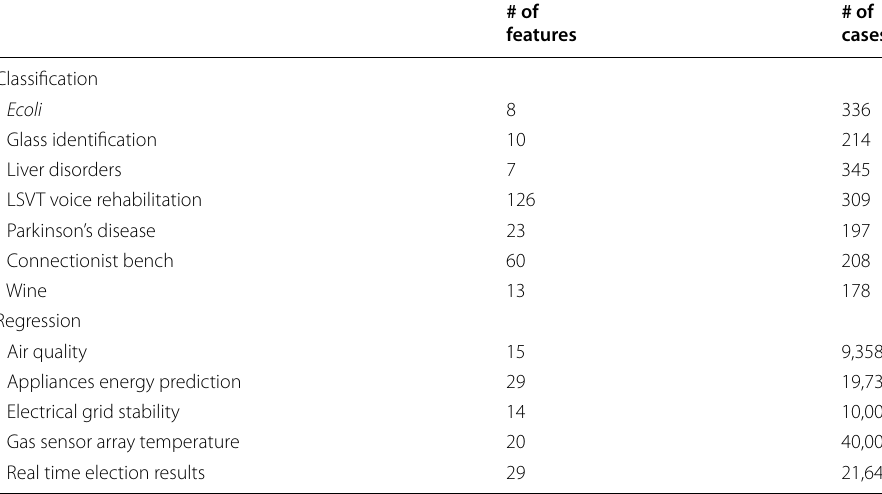
Table 1 Benchmark data used in this study